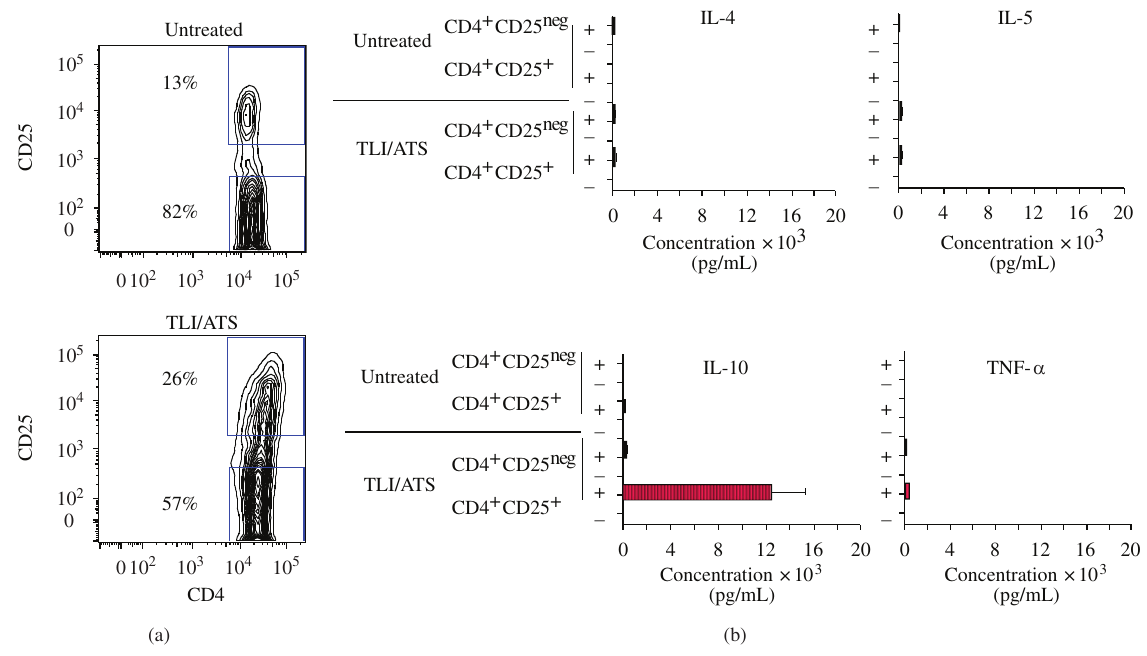
FIGURE 3: Donor CD4 + CD25 + T cells, which expand in vivo after a nonmyeloablative HSCT conditioning regimen, secrete IL-10 but no IL-4 or IL-5. (a) Representative analysis of in vivo expanded donor H-2K b + CD4 + CD25 + T cells sorted from recipient mouse spleen at day 6 after allogeneic bone marrow transplantation. (b) Cytokine profile of sorted CD4 + CD25 + T cells. H-2K b + CD4 + CD25 + and H- 2K b + CD4 + CD25 − splenocytes were sorted from spleens of wild-type C57BL/6 mice (untreated, UNT) or from wild-type BALB/c hosts conditioned with TLI/ATS, transplanted with bone marrow and spleen cells from a wild-type C57BL/6 donor, and harvested on day 6 after transplant. A total of 4 × 10 4 cells/well were incubated in triplicate wells for 72 hrs with or without 10 ng/mL myristate acetate (PMA) + 2 μ M ionomycin. Supernatants were analyzed by 22-plex Milliplex Map mouse cytokine/chemokine kit (Millipore, Mass, USA). Data represent means ± SEM of triplicate wells in 3 experiments, n = 4 – 6 mice per experiment (TLI/ATS group) and n = 5–7 mice per experiment (Untreated group). TLI/ATS: total lymphoid irradiation/anti- thymocyte